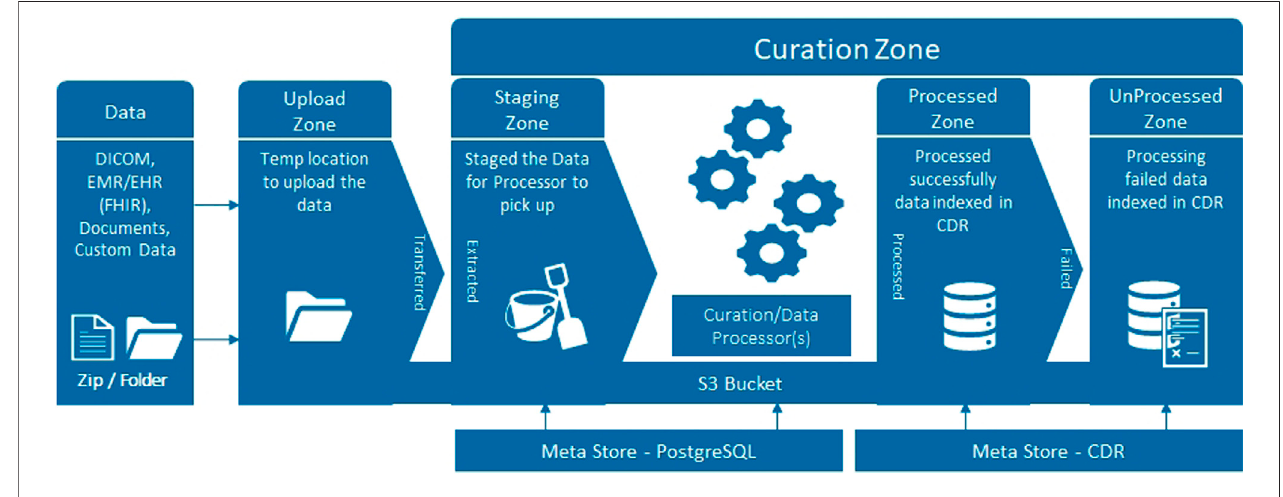
FIGURE 2 | Schematic diagram of the upload work fl ow of the CDL.